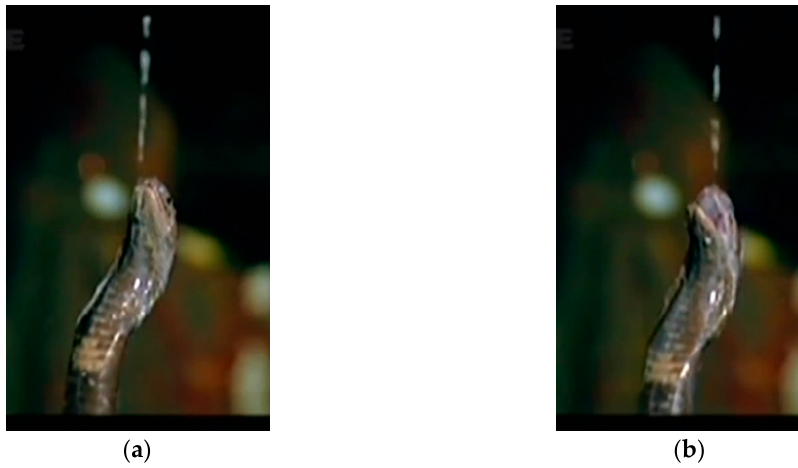
Figure 1. Stills from the movie Devi (Ramakrishna 1999). ( a ) A stream of milk gushes over the head of a cobra, who is worshipped as a goddess; ( b ) She opens her mouth to drink the milk. N¯agas are often worshipped in front of termite hills (cf. König 1984); in the Himalayas, they are believed to dwell in springs (cf. Handa 2004; Lange 2017). These habitats highlight their relationship to fresh water, as well as to the earth;